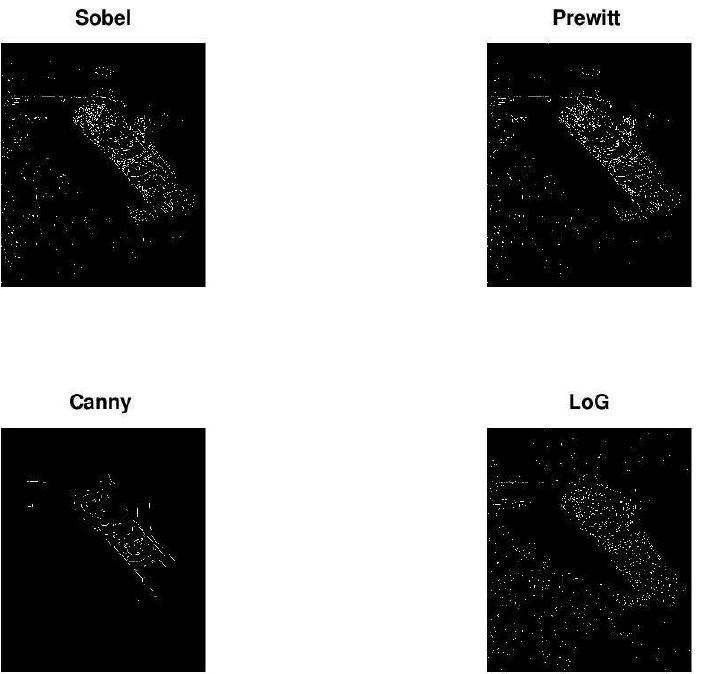
Figure 7. Result of edge detection with common filters (selected parameters).